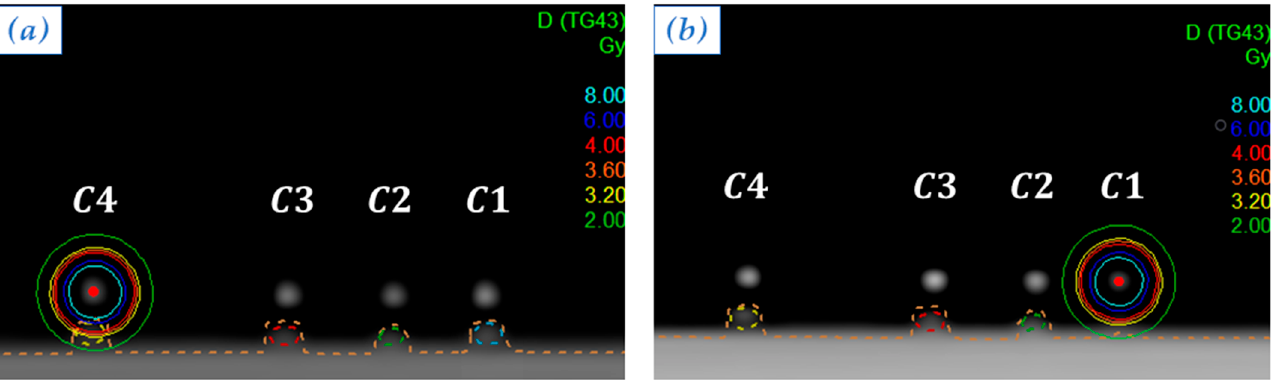
Figure 5. Isodose curves obtained by optimizing the 3 mm slice thickness plan with four active dwell positions ( a ) and the 1 mm slice thickness plan with four active dwell positions ( b ). Each color cor- responds to a dose value, as reported in the legend The second one is computed on a 1 𝑚𝑚 CT slice thickness in the axial direction and was delivered twice. Images of minor slice thickness allows a better location of TLD, im- proving the accuracy in dose delivery. Optimized isodose curves are shown in Figure 5b. 3. Results 3.1. TLD-100 Characterization Results from previously discussed irradiations for TLD characterization are pre- sented. 3.1.1. Sensitivity Factors After being exposed to a uniform dose of 2 Gy, each dosimeter of the batch was read ( R i ). The arithmetic mean 𝑅(cid:3364) was calculated, and each sensitivity factor was evaluated as: